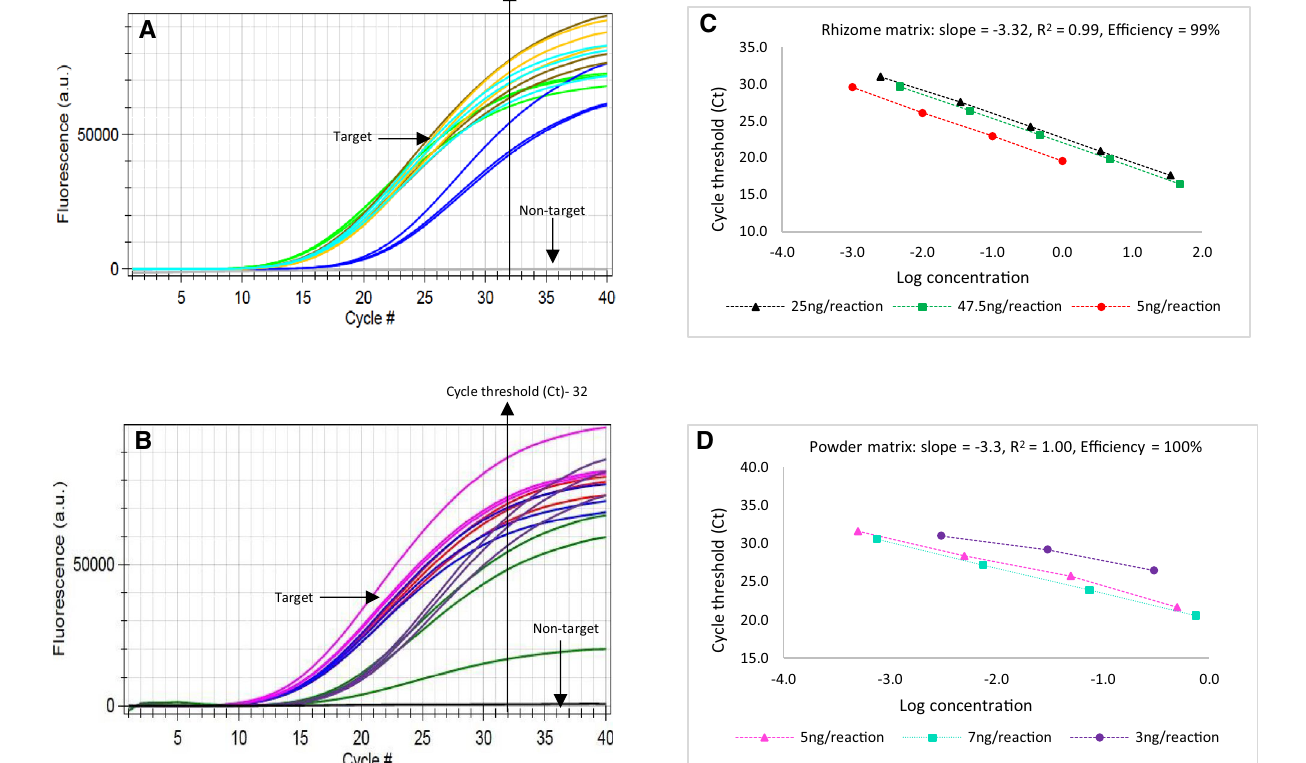
Figure 1. In ( A , B ), the X-axis represents the threshold cycle, and Y-axis represents the fluorescent units. Evaluating the specificity of A. racemosa qualitative PCR assay using 20 target samples and 20 non-target samples using bCUBE instrument. All target samples successfully amplified with Ct values ranging from 18 to 22, for different sample matrices [Standard Botanical Reference Material (SBRM), rhizome and powder]. Non-target samples did not amplify. ( C , D ) Efficiency of A. racemosa qualitative PCR assay for rhizome and powder matrices. ( C ) Six 10-fold dilution series were prepared from 25 ng, 47.5 ng and 5 ng DNA as starting concentration. Each dilution was tested in triplicate. The amplification efficiency was 99% with R 2 = 0.99. ( D ) Six 10-fold dilution series were prepared from 5 ng, 7 ng and 3 ng DNA as starting concentration. Each dilution was tested in triplicate. The amplification efficiency was 100% with R 2 =